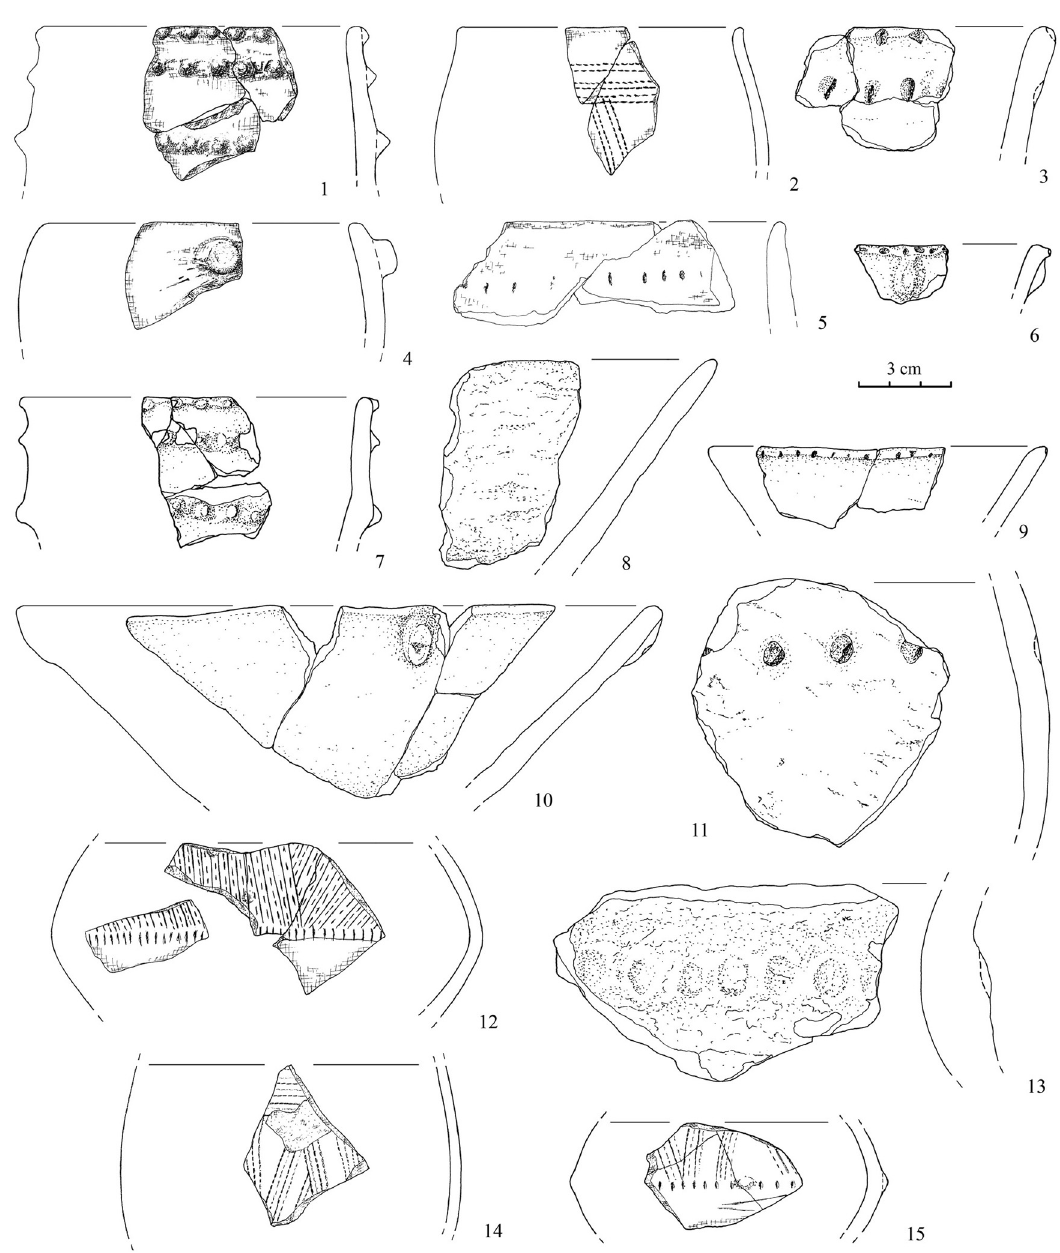
Figure 5: Ł oniowa, com. D ę bno, site 18, features 7 ( 3 – 11, 13 ) , 9 ( 1 – 2, 12, 14 – 15 ) . Selected Malice Culture